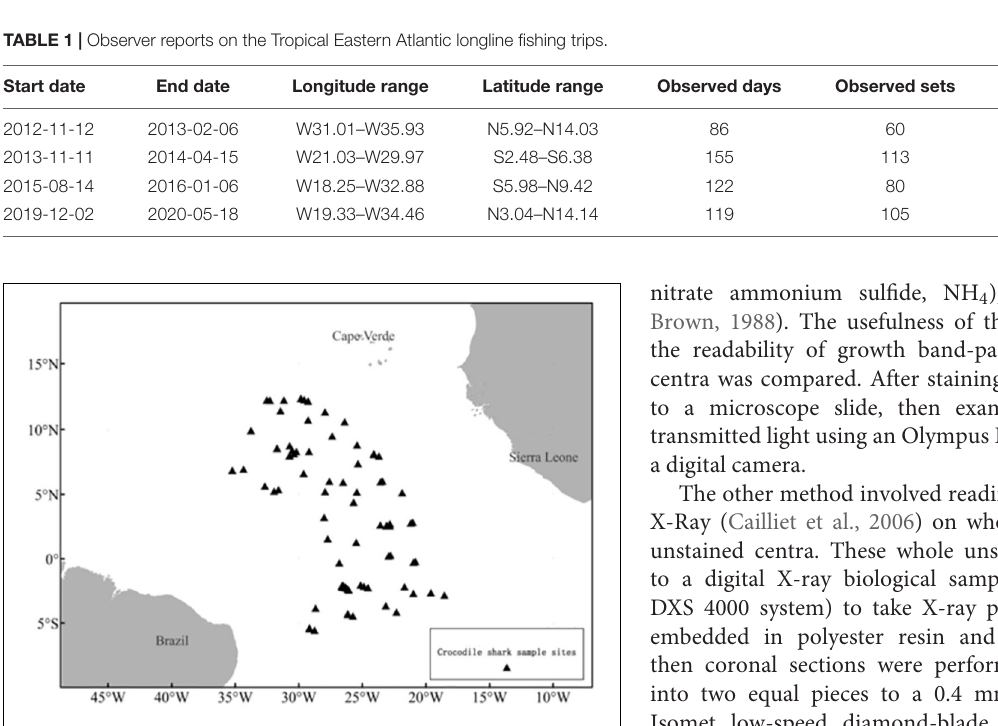
FIGURE 1 | Set locations where P. kamoharai specimens were collected by the Chinese longline Fishery Observer in the Tropical Eastern Atlantic